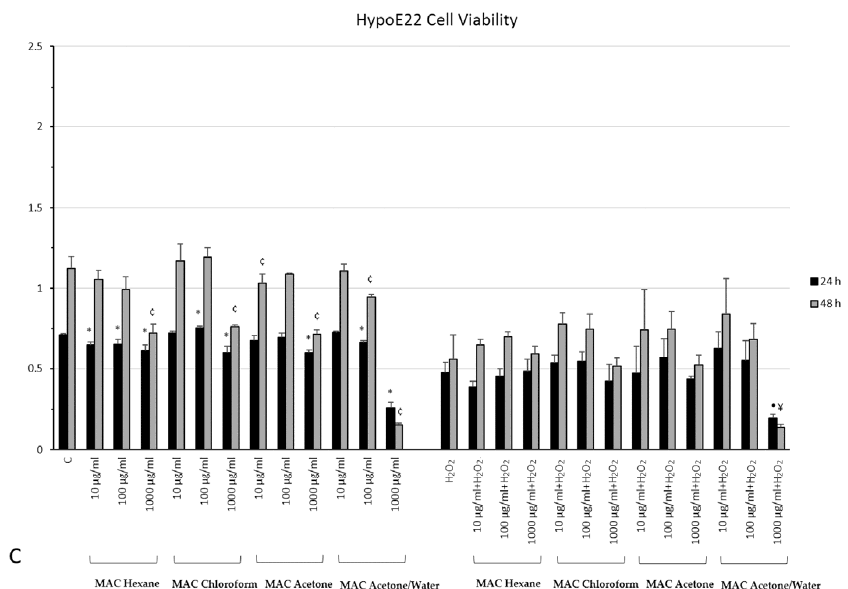
Figure 3. MTT assay of HypoE22 hypothalamic cell line exposed different concentrations (10–1000 µ g/mL) of different M. spicata extracts for 24 and 48 h. Extracts with HAE ( A ), UAE ( B ) and MAC ( C ) methods are shown. The data graph bars are the mean ± SD ( n = 3). * p < 0.05 vs. 24 h C; • p < 0.05 vs. 24 h H 2 O 2 ; ¢ p < 0.05 vs. 48 h C; ¥ p < 0.05 vs. 48 h H 2 O 2 .